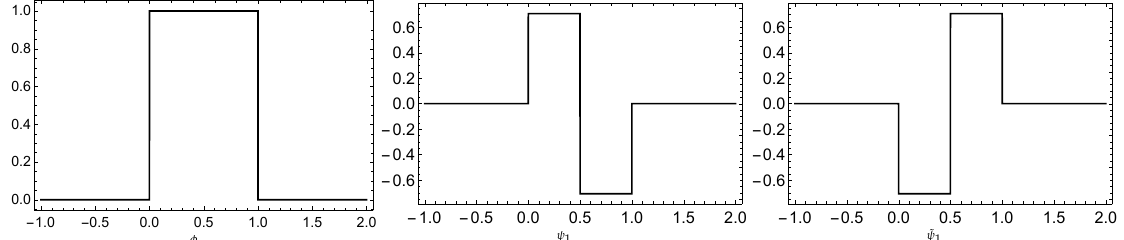
Figure 3. The graph of the Haar dual tight framelet of Example